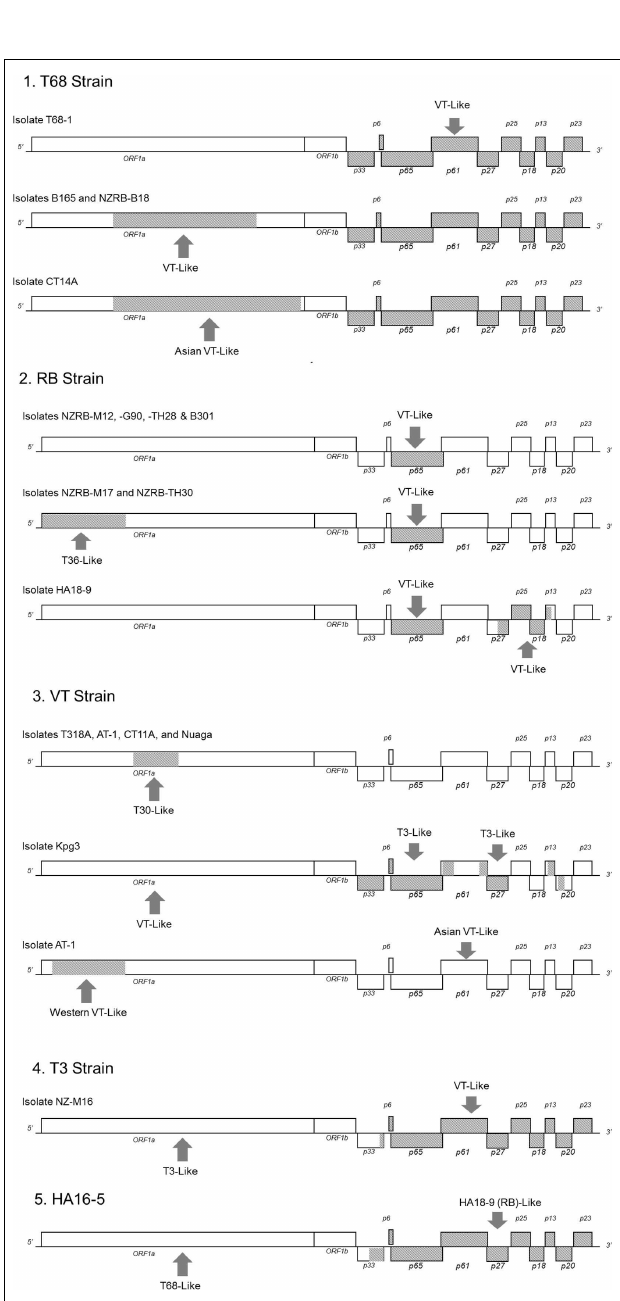
FIGURE 4 | Location and origin of the recombination events present in CTV isolates examined in this study, divided by strain .